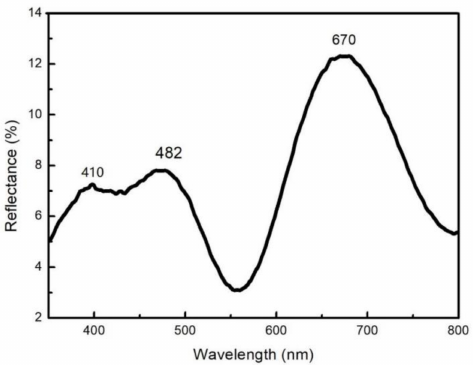
Figure 8. The reflection spectrum of the alumina-Co composite film shown in Figure